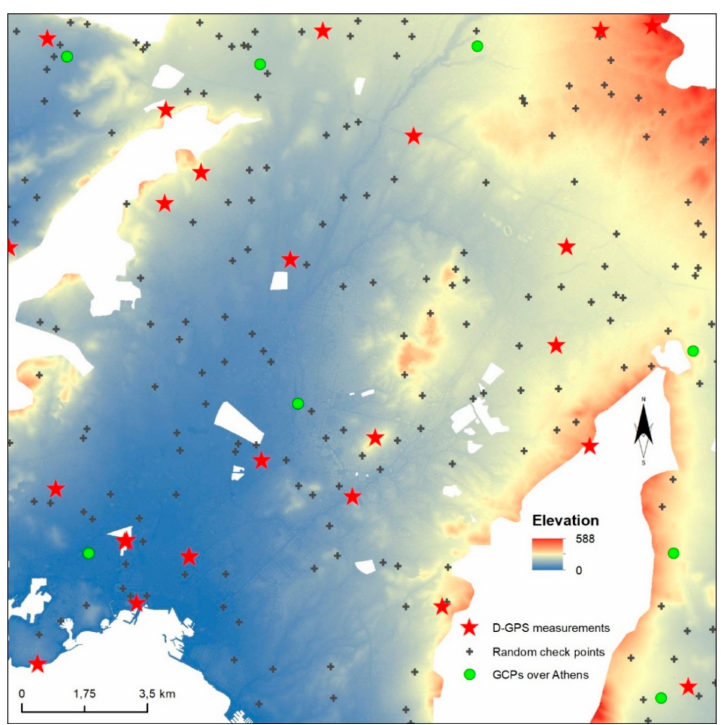
Figure 4. The project area with overlaid the reference DSM, the dataset of GCPs, the random check points, and the d-GPS measured